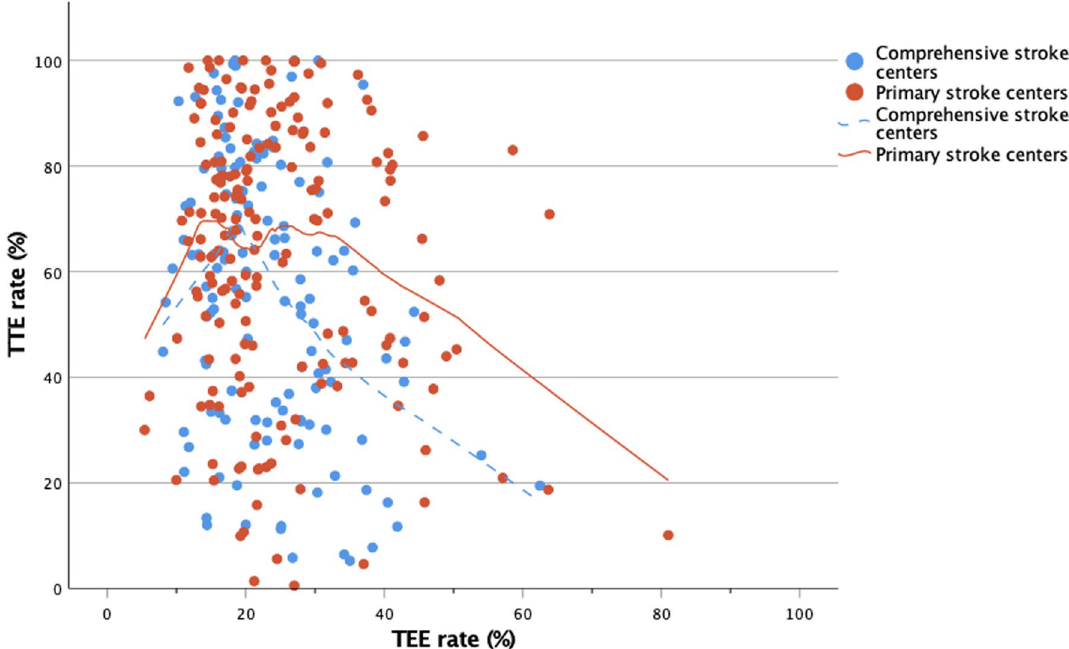
Fig. 2 TTE rates in relation to TEE rates per department. Higher TEE rates resulted into lower TTE rates and departments with primary stroke centers had higher TTE rates than departments with comprehensive stroke centers. Both effects can be observed in particular above TEE rates of 20%